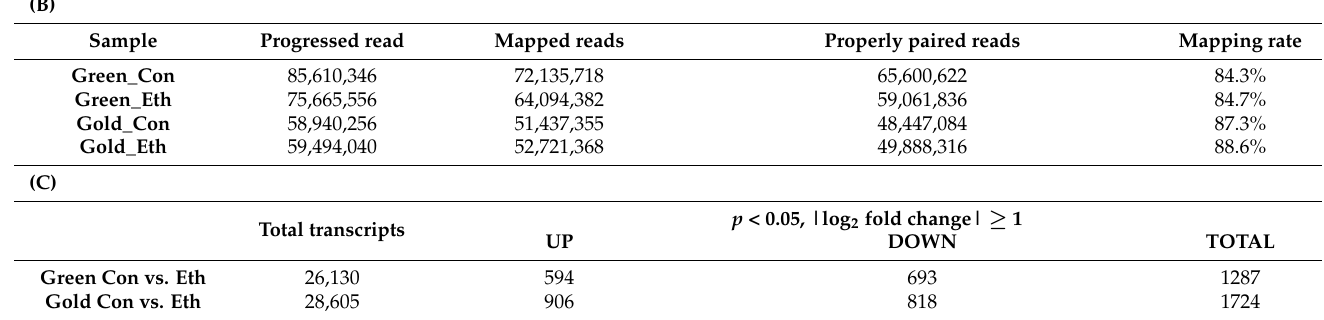
Figure 1. GO classification of the DEGs of control vs. ethylene in ( A ) green ‘Hayward’ and ( B ) gold ‘Haegeum’ kiwifruit.